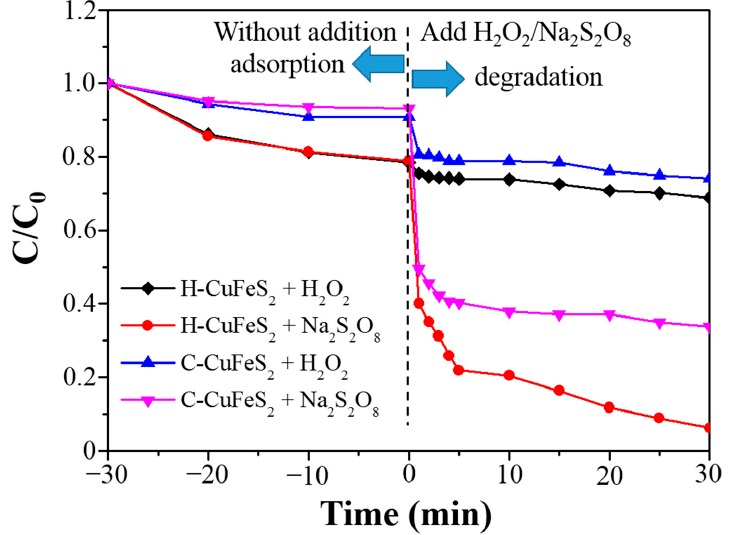
Figure 7. Fenton and Fenton-like reactions for RhB degradation at different conditions: H-CuFeS 2 in the presence of H 2 O 2 (black), H-CuFeS 2 in the presence of Na 2 S 2 O 8 (red), C-CuFeS 2 in the presence of H 2 O 2 (blue), and C-CuFeS 2 in the presence of Na 2 S 2 O 8 (pink).